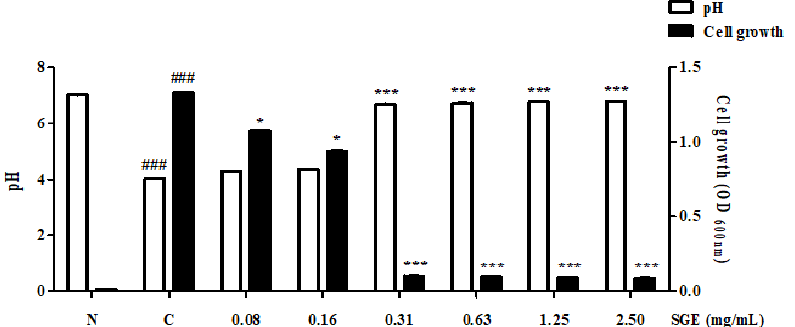
Figure 5. Inhibition of acid production of SGE. After treating S. mutans with the indicated con- centration of SGE for 24 h, the amount of acid production was measured using a pH meter, and bacterial growth was measured using a spectrophotometer. Values are mean ± SD; ### p < 0.001 vs. non-treated group, * p < 0.05, and *** p < 0.001 vs. 1% sucrose-treated group.